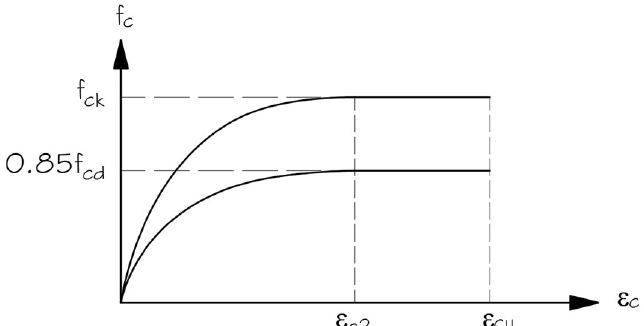
Figure 1. Concrete constitutive model for compression, for which 0.85f cd and f ck correspond to the design and characteristic strength, respectively [9]